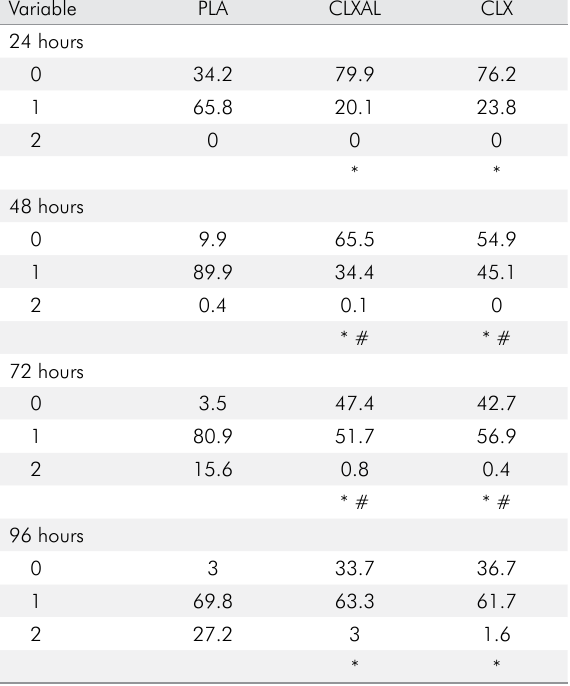
Table 1. Intention-to-treat analysis of the percentage of scores 0, 1 and 2 for all tooth surfaces, with placebo, alcohol-containing 0.12% chlorhexidine solution and alcohol-free 0.12% chlorhexidine solution (n = 35).